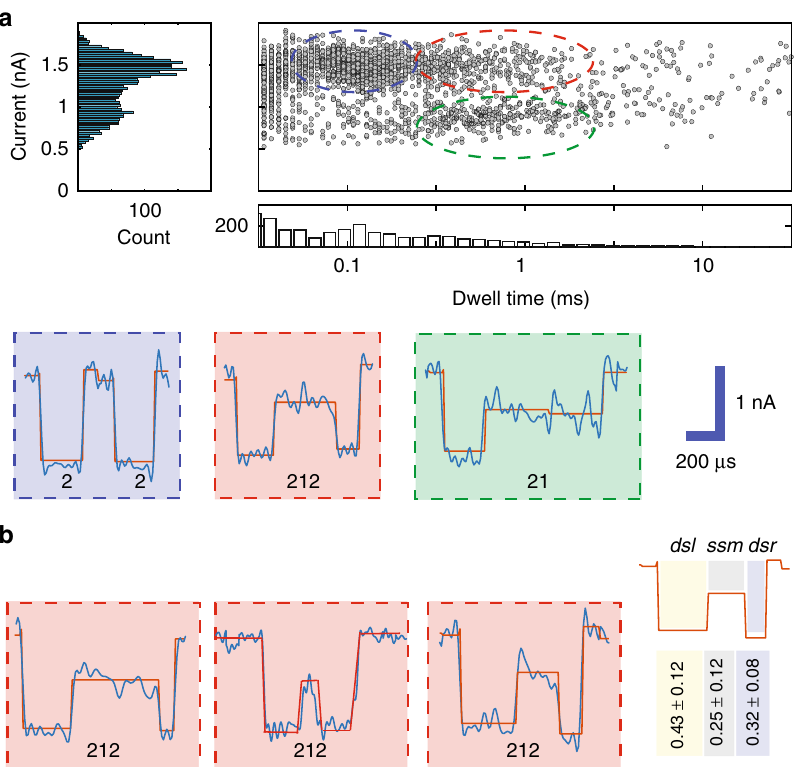
Fig. 2 a Scatter plot of a translocating ds – ss – ds DNA complex in a nanopore. Three clusters (blue, red, and green) denote the events that can be seen from the plot. Representative events for each cluster are listed below and denoted as “ 2 ” , “ 212 ” , and “ 21 ” , respectively. A routine CUSUM 47 method is used to fi t the multi-levels. b For “ 212 ” type events, a large intramolecular velocity variation is observed. The propositional average translocating time for each segment is calculated statistically (using 31 molecules). Source data used to generate this fi gure can be found in the Source Data fi